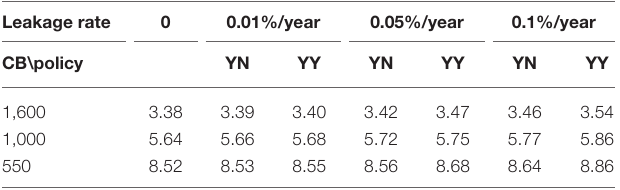
TABLE 3 | Policy Cost with respect to BAU for different leakage rates and pricing policies [% of GDP]. Leakage